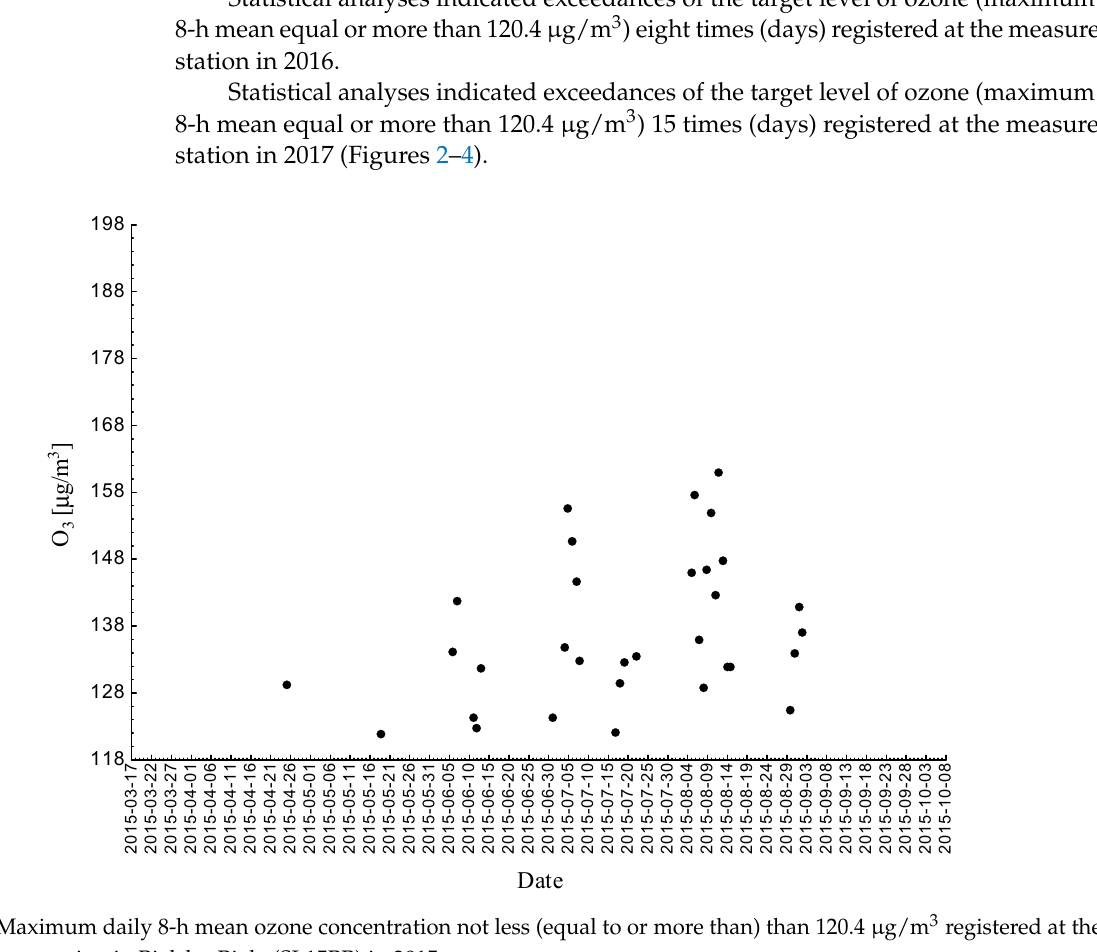
Figure 2. Maximum daily 8-h mean ozone concentration not less (equal to or more than) than 120.4 µ g/m 3 registered at the measurement station in Bielsko-Biała (SL15BB) in